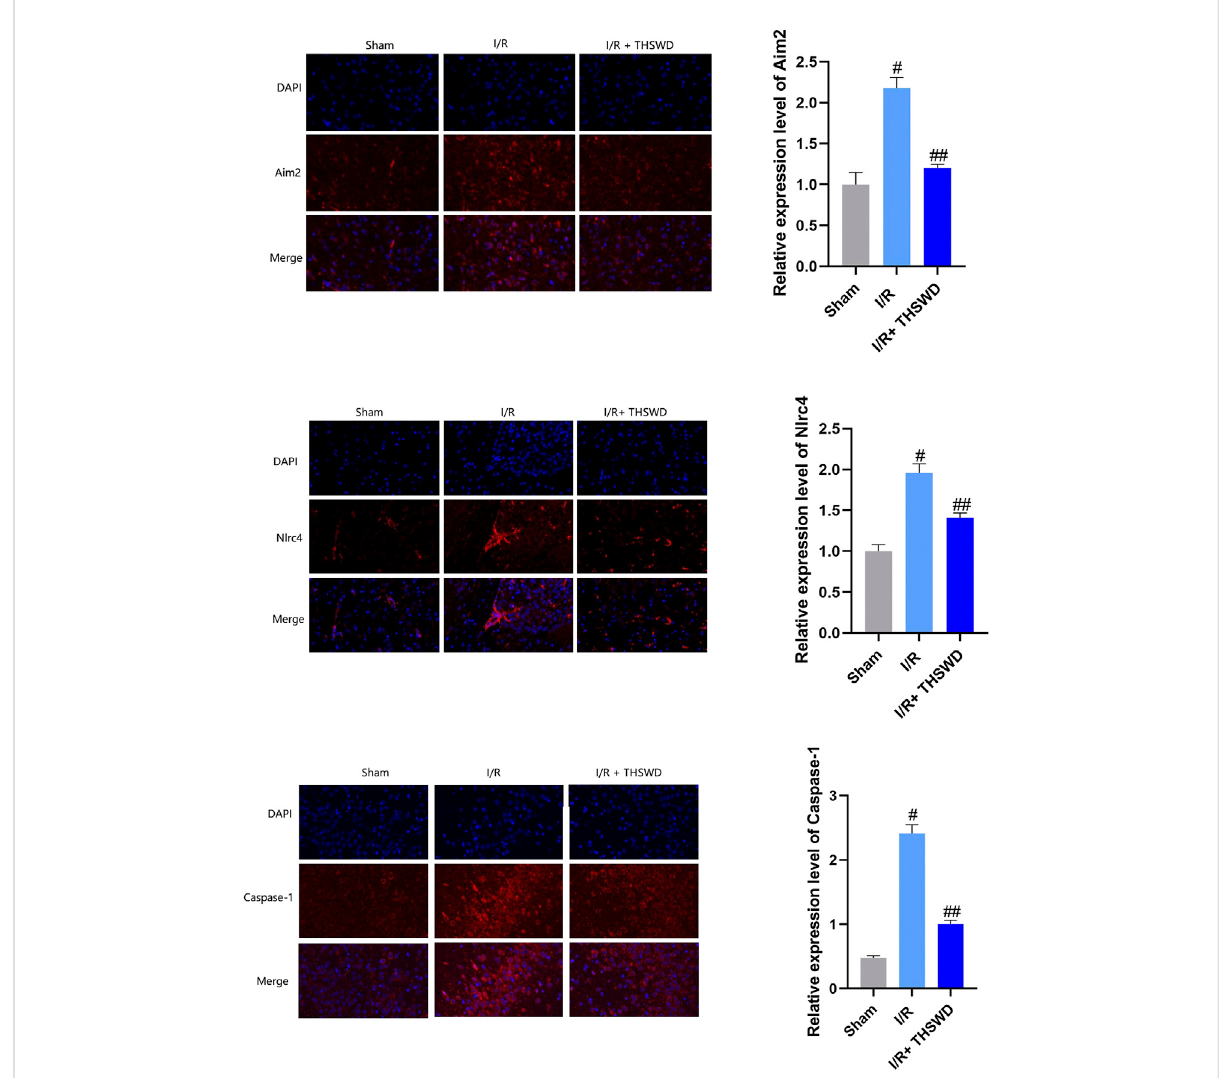
FIGURE 3 Expression of absent in melanoma 2 (AIM2), NLRC4, and caspase-1 in fl ammasomes in animal models. Notes: # p < 0.01 vs. Sham group; ## p < 0.01 vs. I/R